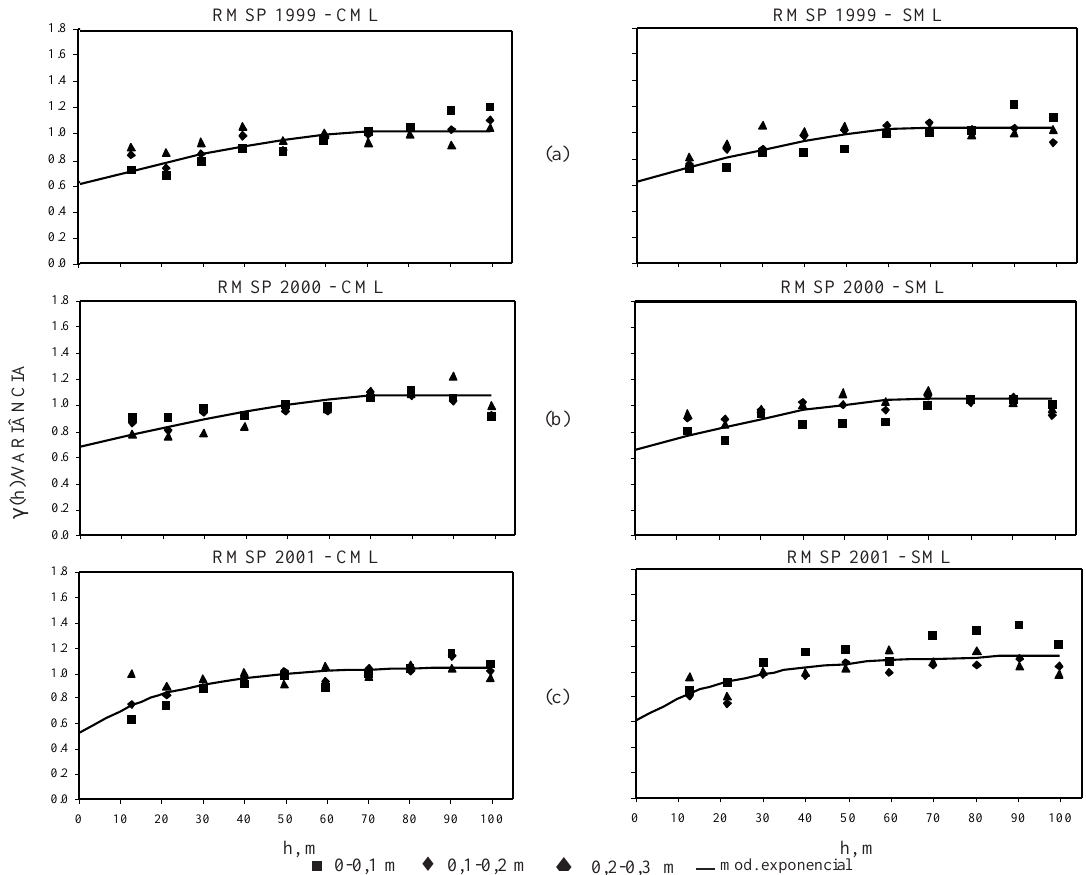
Figura 2. Semivariogramas escalonados para a variável RMSP 1999 (a), 2000 (b) e 2001 (c), avaliada nas camadas de 0-0,1, 0,1-0,2 e 0,2-0,3 m, nas parcelas com e sem manejo químico localizado (CML e SML,